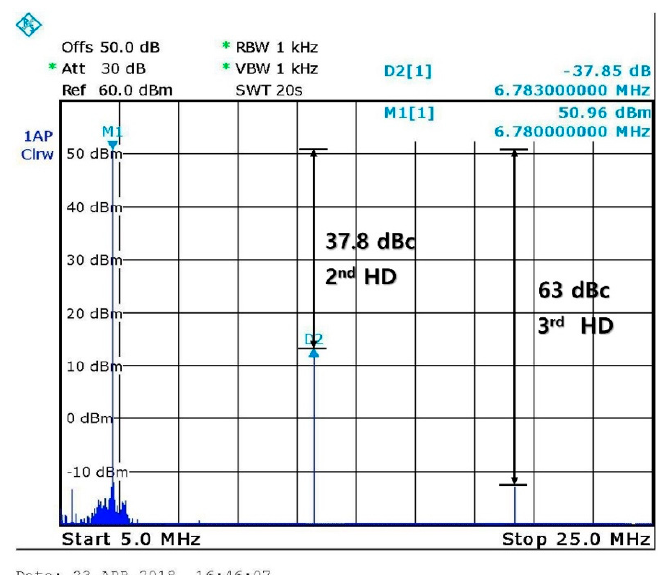
Figure 14. Output spectrum of the proposed power module.